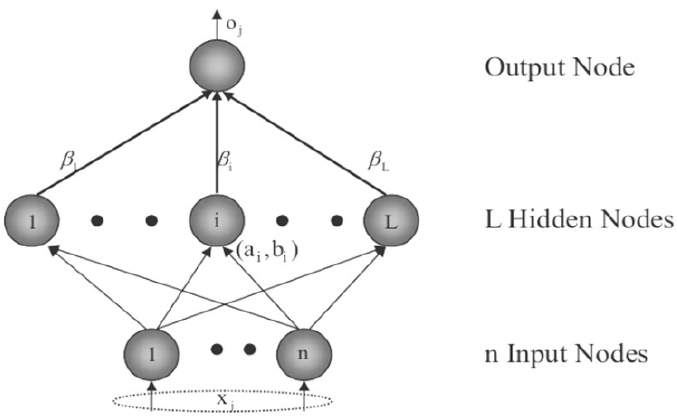
Figure 1. The structure of the ELM.